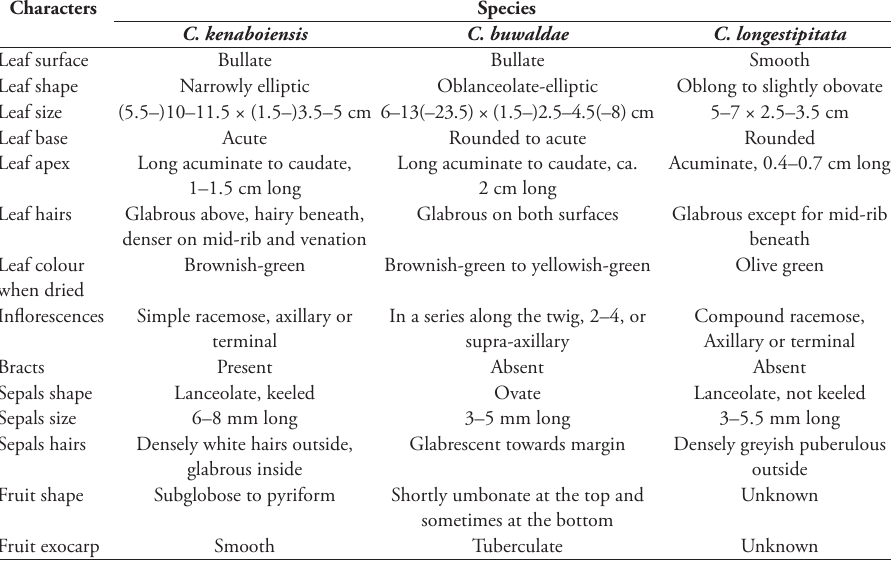
Table 1. Morphological comparison of Capparis kenaboiensis , C . buwaldae and C . longestipitata .